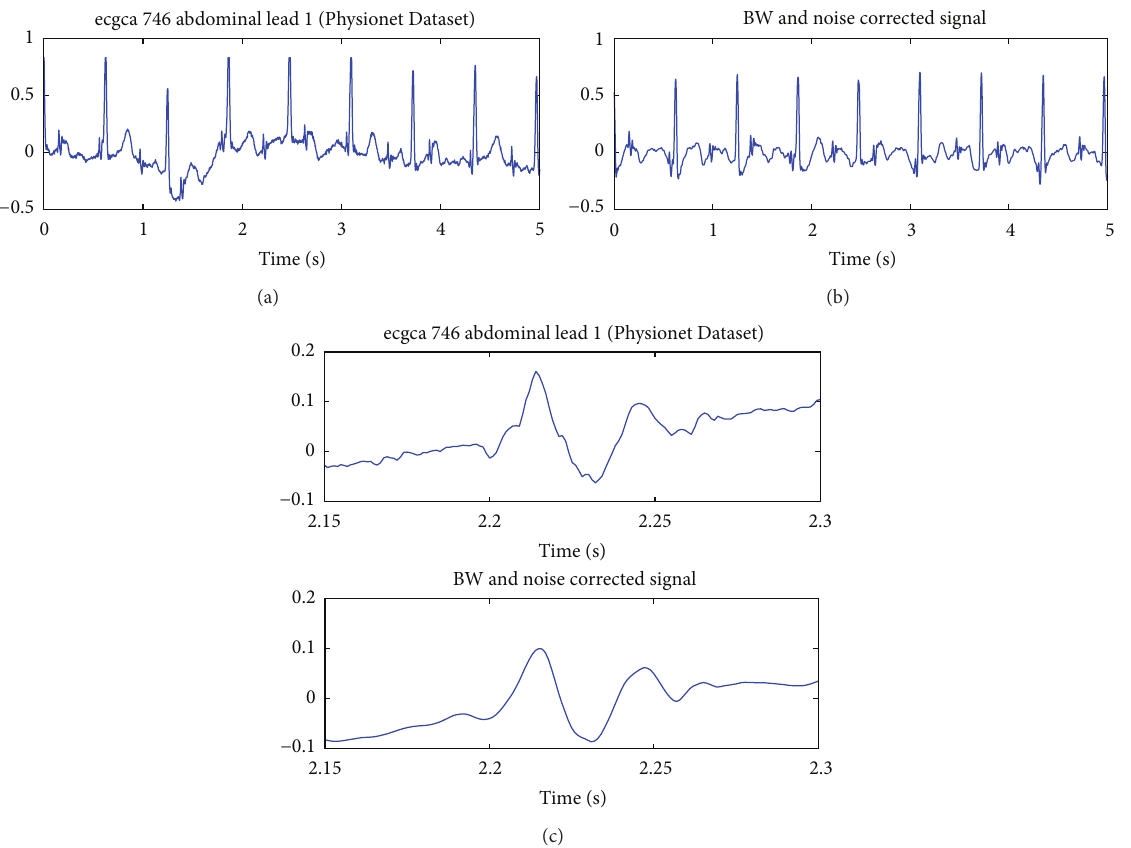
Figure 7: ecgca 746 abdomen lead 1 Noninvasive Fetal ECG Database (Physionet Dataset): (a) signal; (b) BW and noise corrected signal; (c) signals